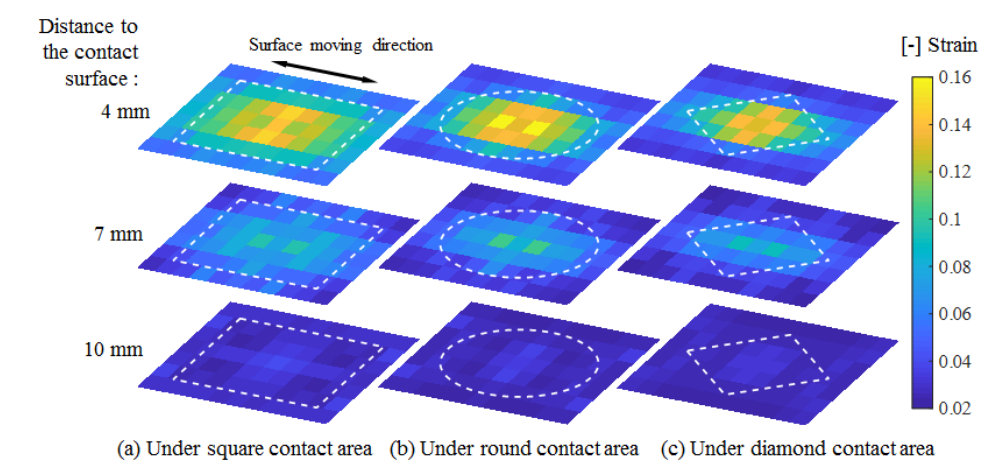
Figure 11. Distributions of shear strain amplitude detected from 24 units of PVDF films extended by the central symmetry under three contact shapes plotted under the same range